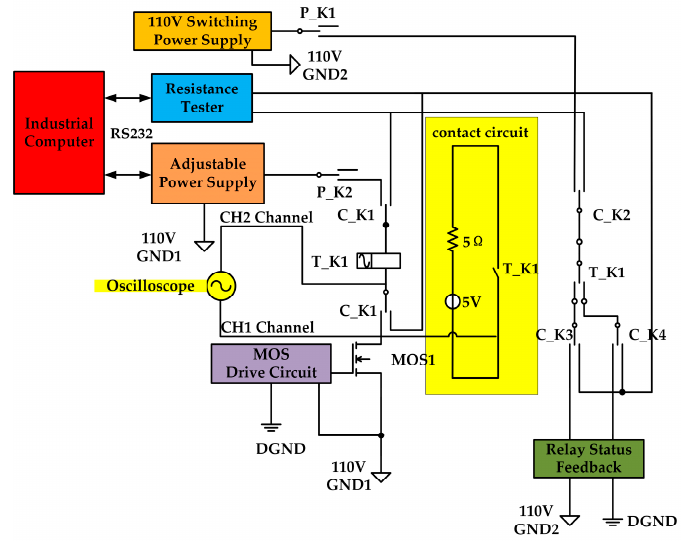
Figure 6. Test method of closing time.